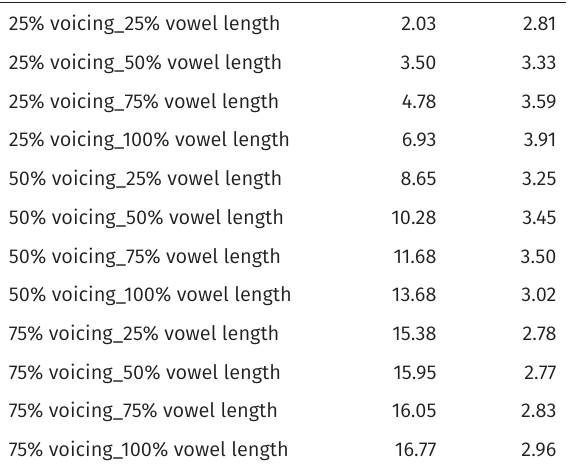
Table 7: Identification rates of [z] in each of the patterns tested (number of tokens per pattern = 18; number of participants = 40).